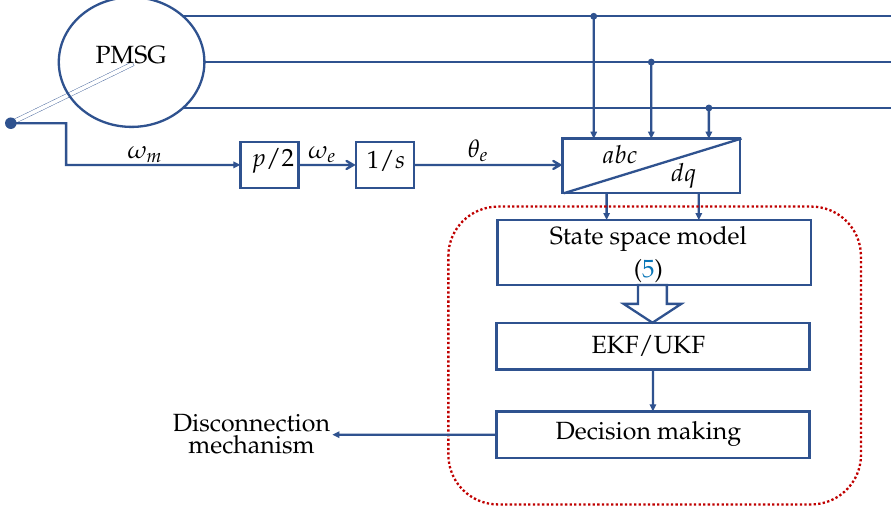
Figure 5. Inter-turn fault detection based on